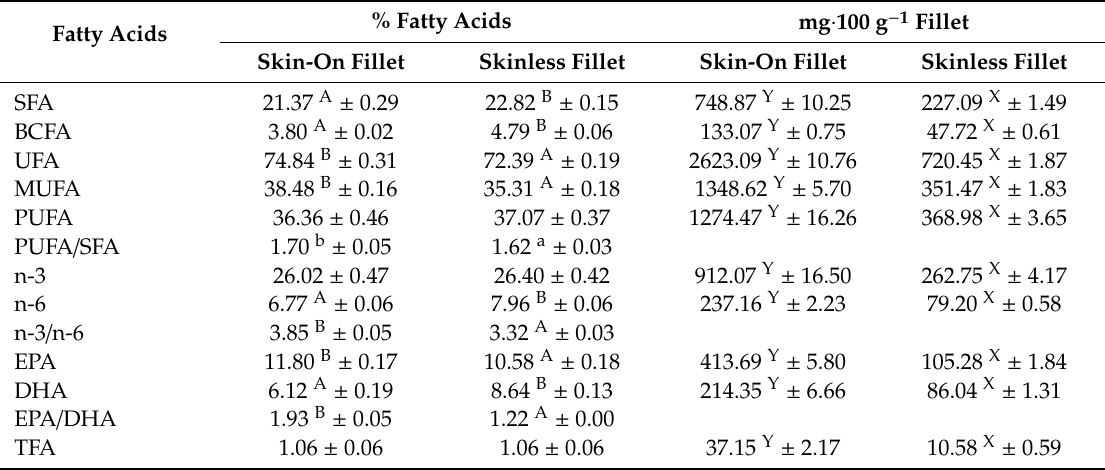
Table2. Fattyacidprofile(%fattyacids)andcontent(mg · 100g − 1 fillet)ofPrussianCarp( Carassiusgibelio ) fillets (mean ±